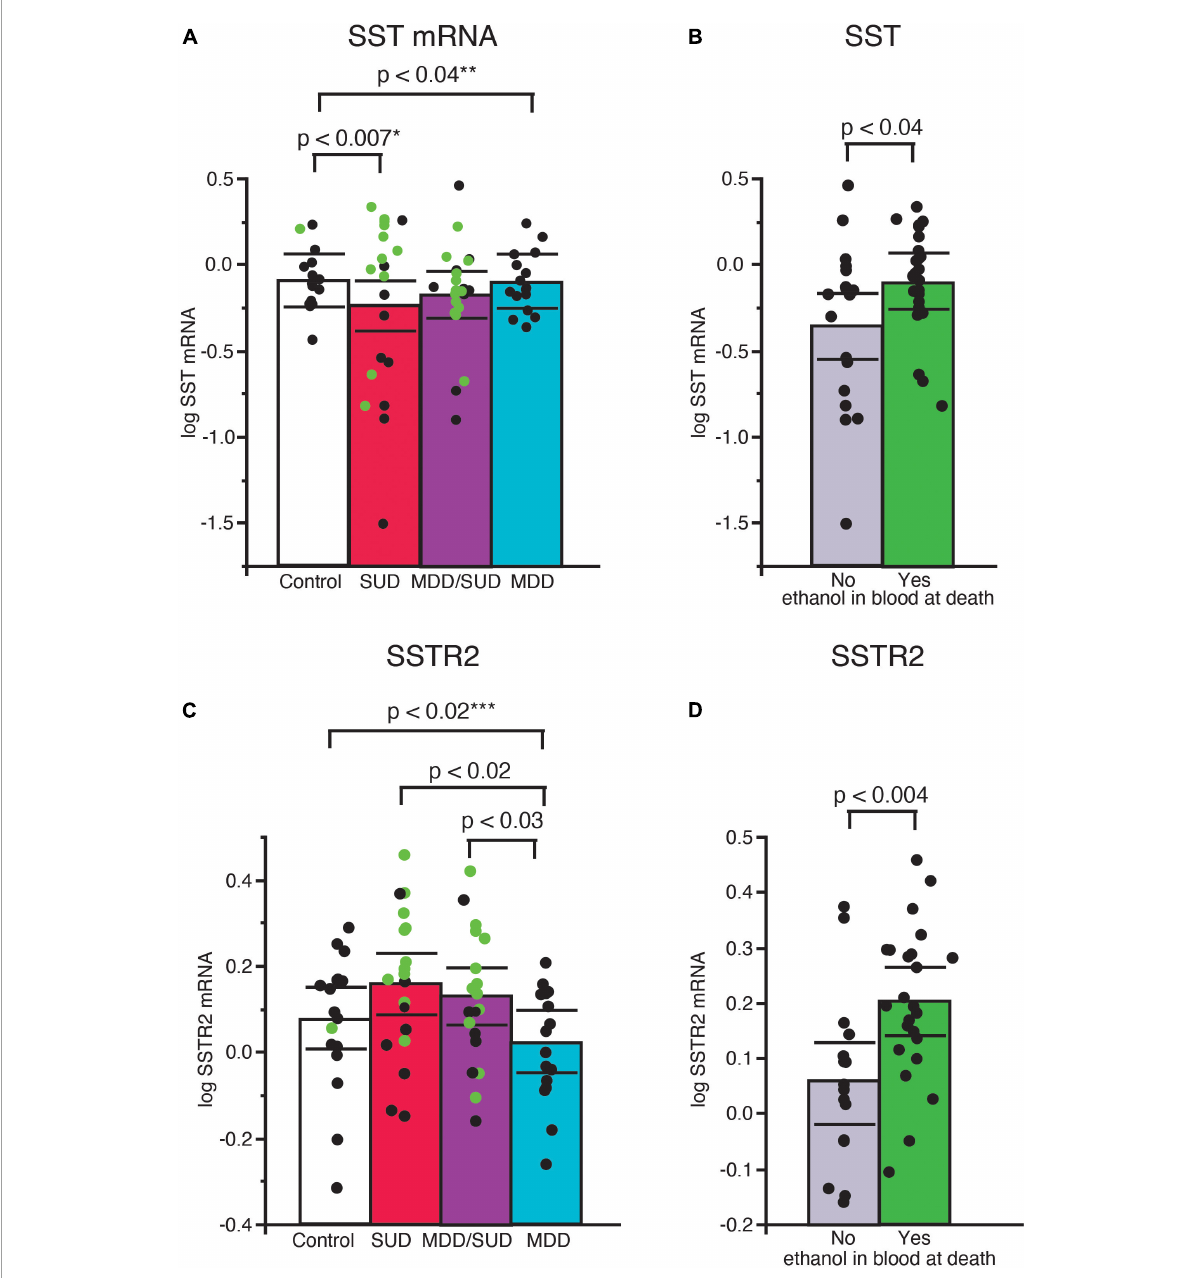
FIGURE2 Altered SST signaling in the hippocampus of subjects with SUD and subjects with MDD. Scatterplots depicting normalized mRNA expression for Sst in each diagnosis group (A) . Green circles represent subjects with alcohol in the blood at death. SST mRNA expression was significantly greater in subjects with SUD compared to control subjects, ( p < 0.0007, *adjusted for effects of alcohol in the blood at death and pH). Subjects with alcohol in the blood at death had significantly greater Sst mRNA expression than subjects without alcohol in the blood (B) . Subjects with MDD/SUD had no significant difference in Sst mRNA expression when compared to control subjects (adjusted for significant effects of age and suicide). A significant decrease in Sst mRNA expression was detected in subjects with MDD ( p < 0.04, **adjusted for effects of age, duration of illness, and PMI). No significant differences in Sstr2 mRNA expression were detected in subjects with SUD compared to control subjects when adjusted for effect of alcohol in the blood at death (C) . Subjects with alcohol in the blood at death had significantly greater expression of SSTR2 mRNA (D) . Subjects with MDD had significantly lower Sstr2 mRNA expression compared to control subjects ( p < 0.02, ***adjusted for effects of smoking history and ZT time). Subjects with MDD also displayed lower Sstr2 mRNA expression in comparison to subjects with SUD or subjects with MDD/SUD (C) . Significance values are derived from stepwise linear regression models. Scatterplots show the mean (histogram) and 95% confidence intervals (black